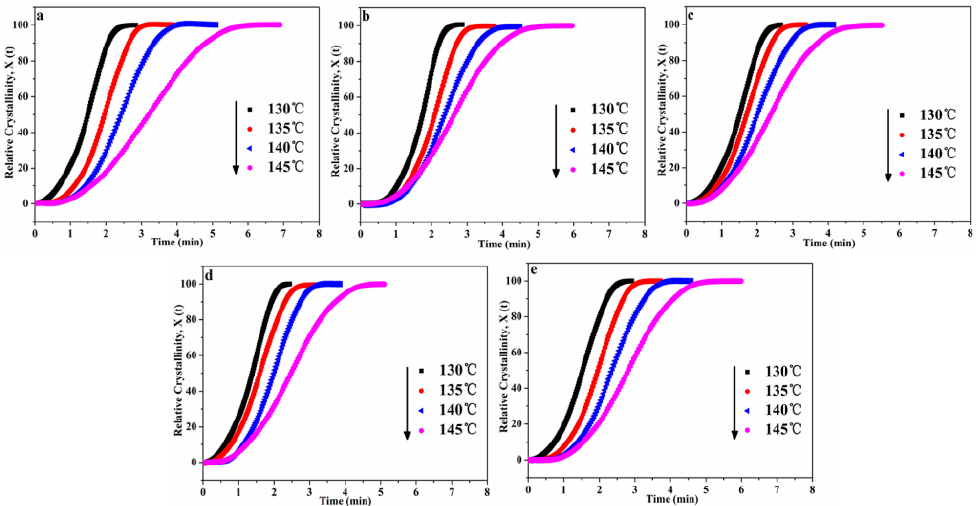
Figure 5. Relative degree of crystallinity ( X t ) as a function of time ( t ) for POM / Ag nanocomposites: ( a ) POM, ( b ) POM ‐ 1, ( c ) POM ‐ 2, ( d ) POM ‐ 3 and ( e ) POM ‐ 4.